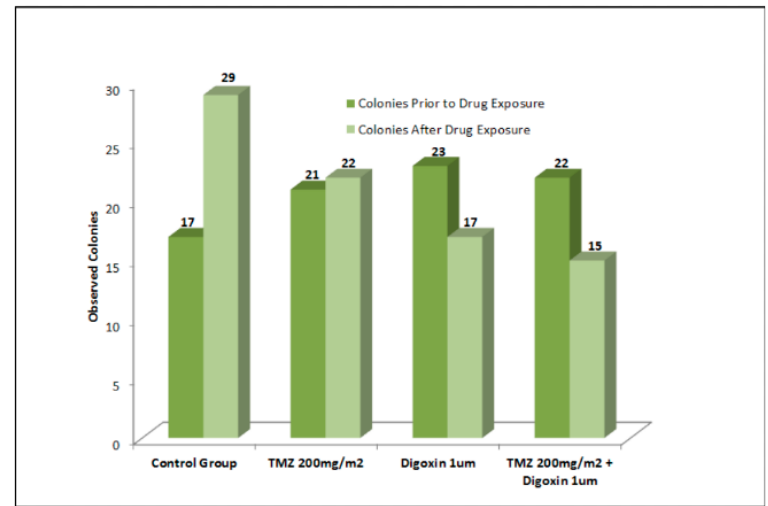
Figure 3. Use of 1 μ M Digoxin inhibited colony formation of T98G cells by 25.41%. With TMZ con- comitant treatment, colony formation was reduced by nearly 30%. T98G soft agar colony formation was not significantly inhibited by TMZ alone.